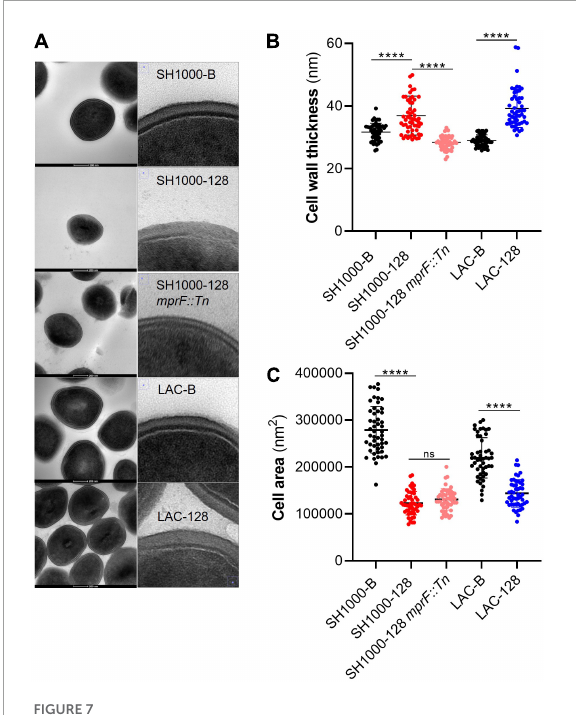
FIGURE7 AHA-1394 resistance is associated with increased cell wall thickness. (A) TEM images of each strain at 300,000x magnification are shown with a 200 nm scale bar. For each strain zoomed in images of just the cell wall are shown on the right. (B) The cell wall thickness in nm of 50 individual cells for each of the strains SH1000-B, SH1000-128, SH1000-128 mprF::Tn , LAC-B and LAC-128. The horizontal line represents the mean and the error bars the standard deviation. (C) The cell area in nm 2 of 50 individual cells for the same panel of strains. The horizontal line represents the mean and the error bars the standard deviation. A one-way ANOVA was performed on SH1000-B, SH1000-128, SH1000-128 mprF::Tn , whereas a paired Student’s t -test was performed between LAC-B and LAC-128. “ns” denotes not significant, significance was determined as the following p values: